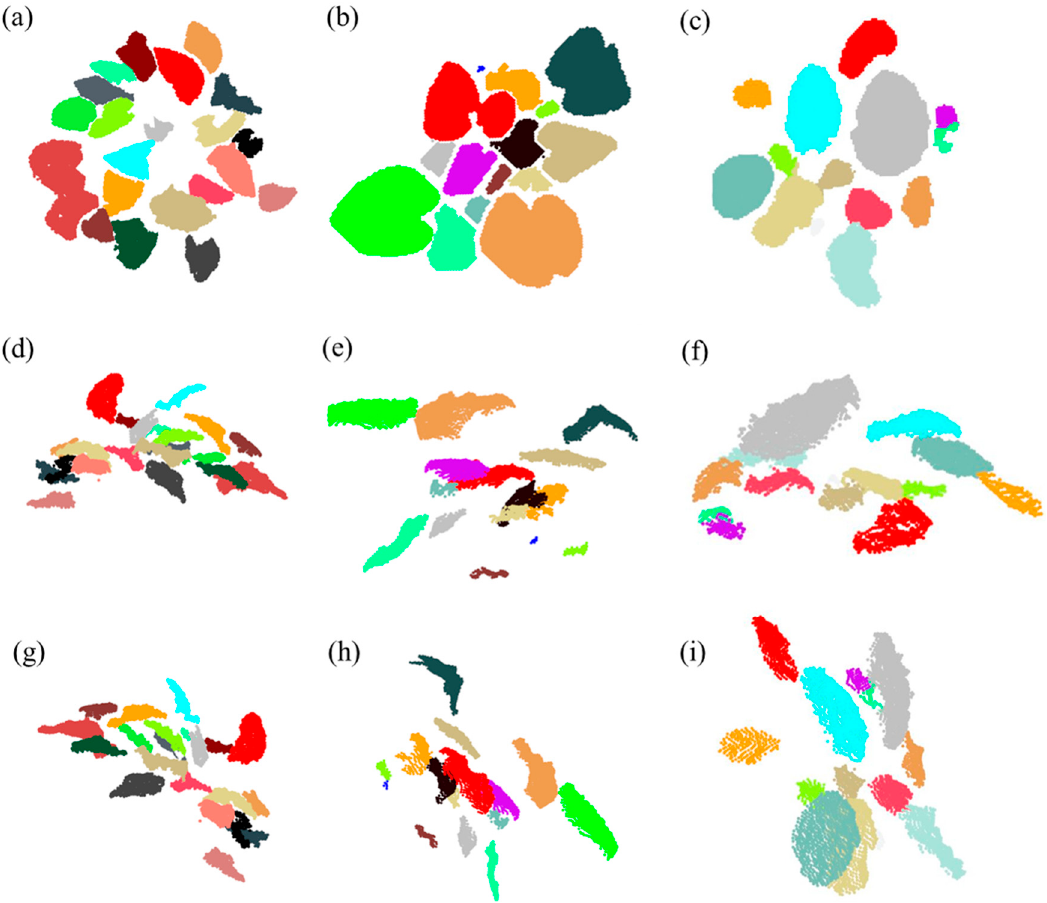
Figure 6. The results of individual leaf segmentation of Epipremnum aureum, Monstera deliciosa, and Calathea makoyana . The left column ( a , d , g ) shows three different views of the result of the point cloud of Epipremnum aureum , respectively. The middle column ( b , e , h ) shows three different views of the result of the point cloud of Monstera deliciosa , respectively. The right column ( c , f , i ) shows three different views of the result of the point cloud of Calathea makoyana , respectively.